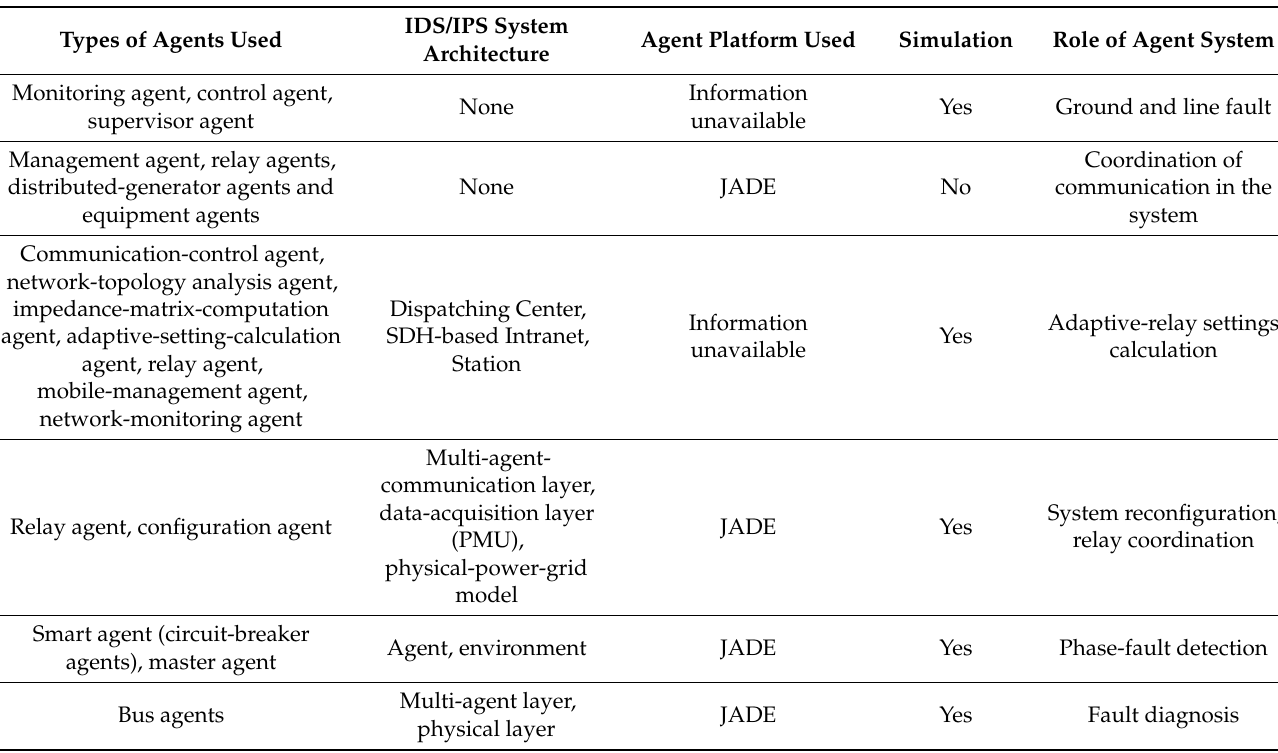
Table 1. Sample software-agent applications in smart-grid